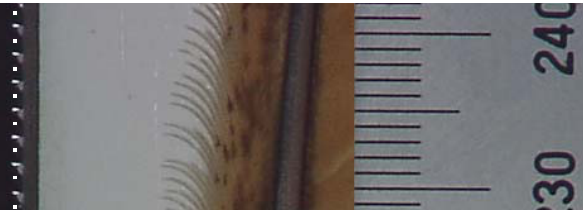
Fig.1(a) Serrations of Bengal Owl and those of 28 Teeth/Inch Serrations Experimented.